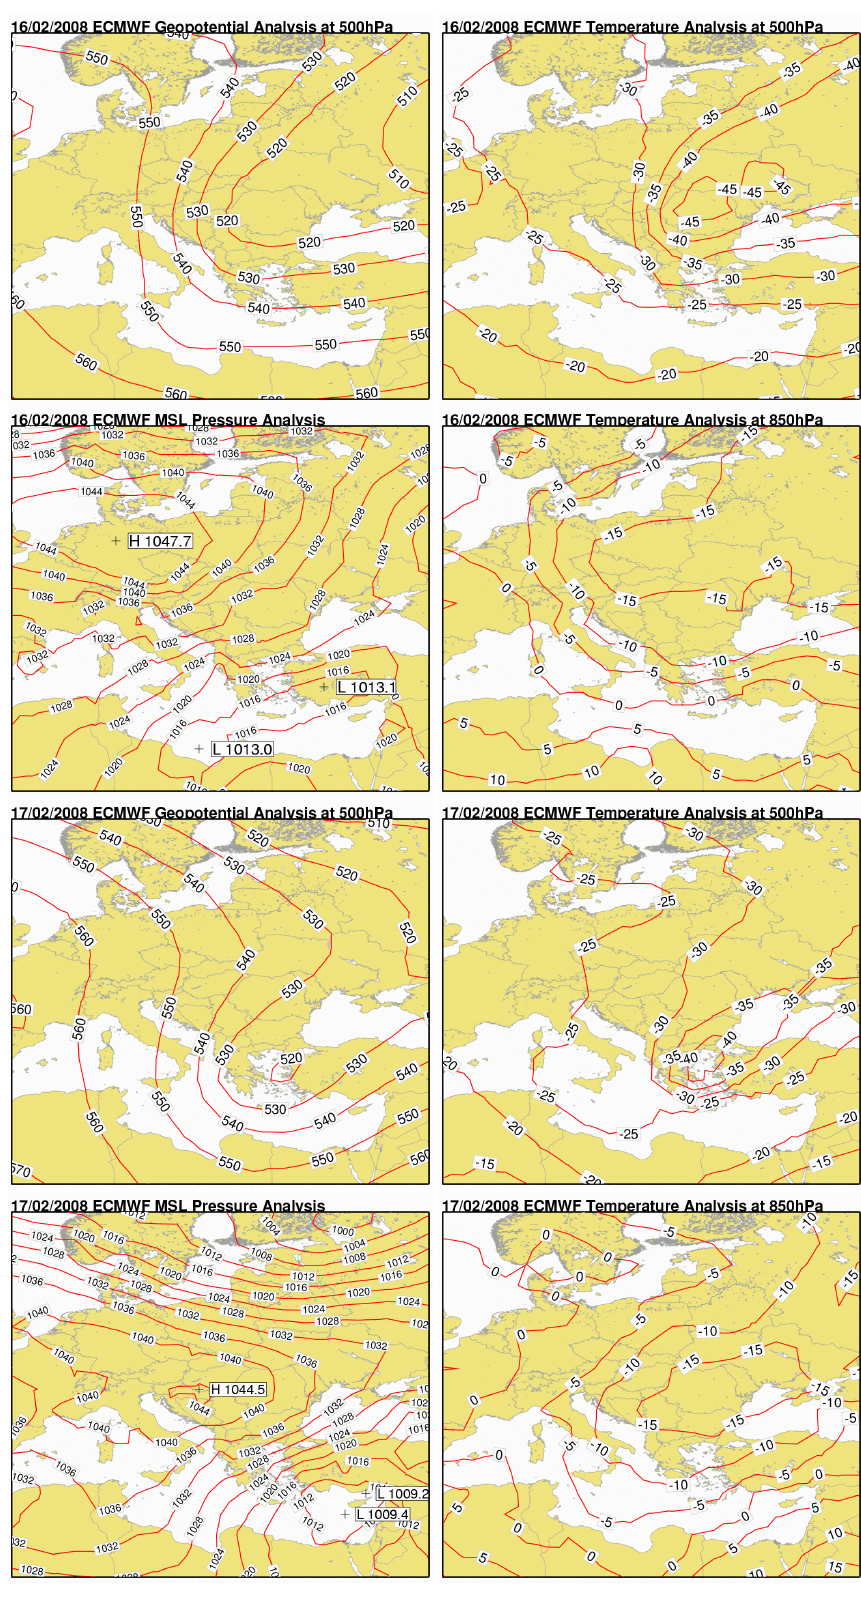
Fig. 1. ECMWF analyses of (a) 500hPa geopotential height (top-left – contour step of 10dam is used) and temperature (top-right – contour step of 5 ◦ C is used), mean sea-level pressure (bottom left – contour step of 4hPa is used) and 850hPa temperature (bottom right – contour step of 5 ◦ C is used) for 16 February 2008 at 12:00UTC and (b) corresponding plots for 17 February